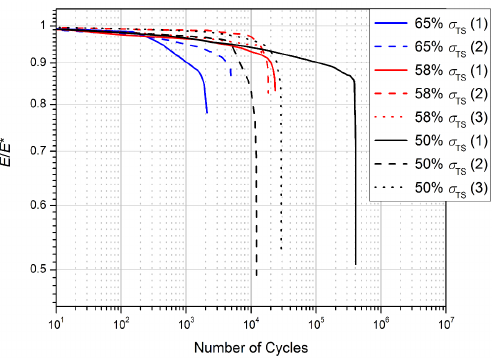
Figure 20. Change in the elastic modulus of C-SMC-Cut-35 during the fatigue testing as a function of the number of cycles.